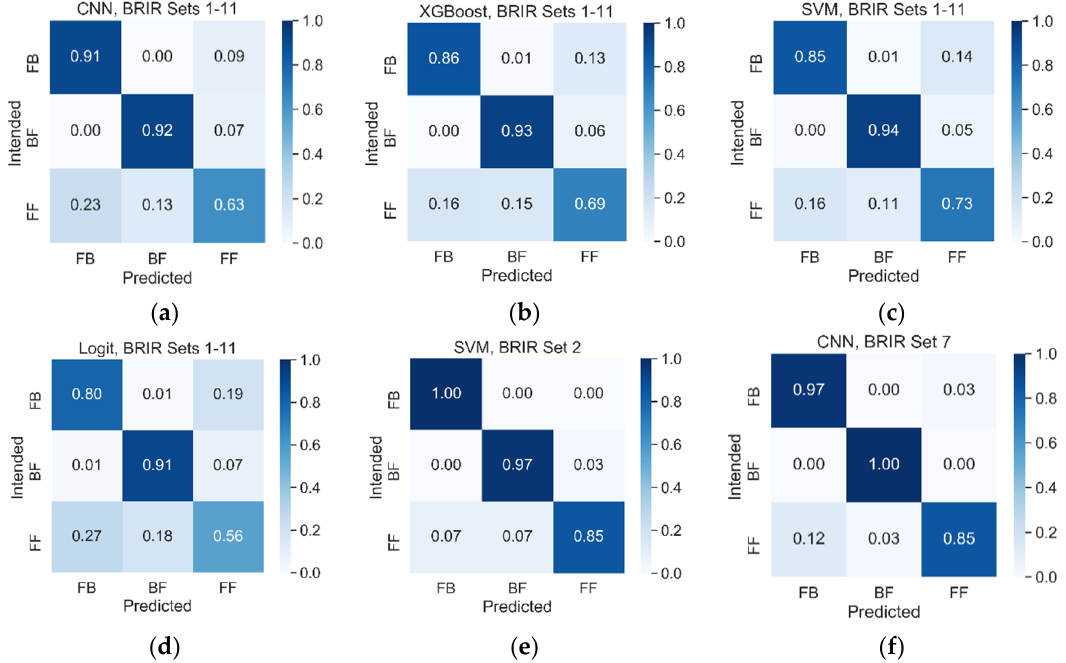
Figure 8. Examples of confusion matrices obtained using machine learning algorithms under BRIR matched conditions: ( a ) convolutional neural network CNN, BRIR sets 1 ‐ 11; ( b ) extreme gradient boosting framework (XGBoost), BRIR sets 1 ‐ 11; ( c ) support vector machine (SVM), BRIR sets 1 ‐ 11; ( d ) logistic regression (Logit), BRIR sets 1 ‐ 11; ( e ) SVM BRIR set 2; ( f ) CNN, BRIR set 7. Vertical axis represents the classification results obtained from the classification algorithms.